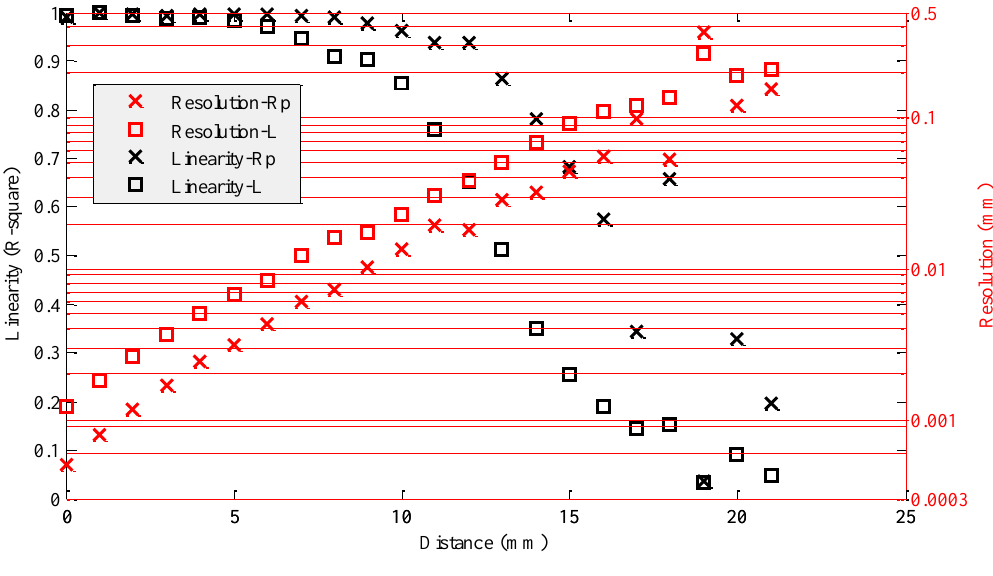
Figure 4. Resolution and Linearity of the outputs of coil 1.